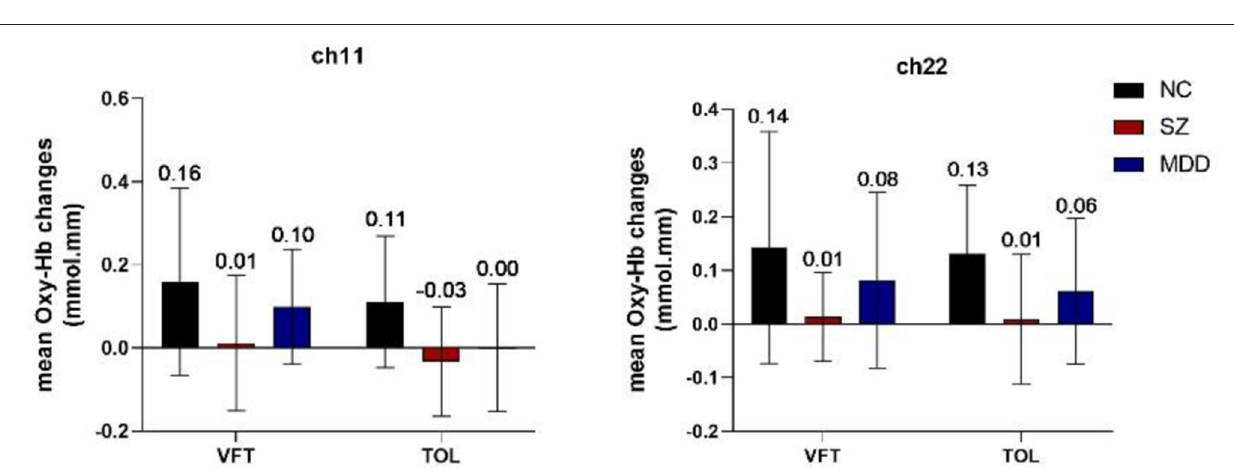
FIGURE 2 | Mean [oxy-Hb] changes in ch11 and